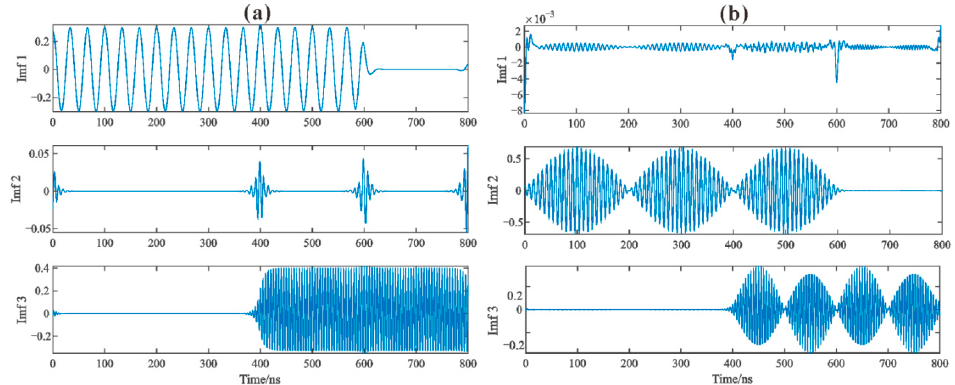
Figure 3. The MVMD decomposition results for ( a ) the simulated channel-1 and ( b ) channel-2.